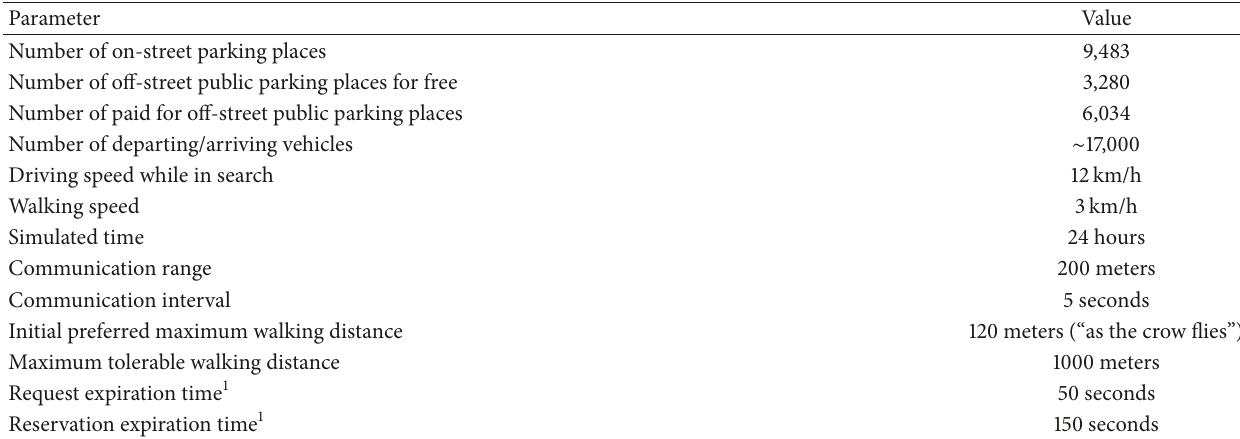
Table 3: Simulation